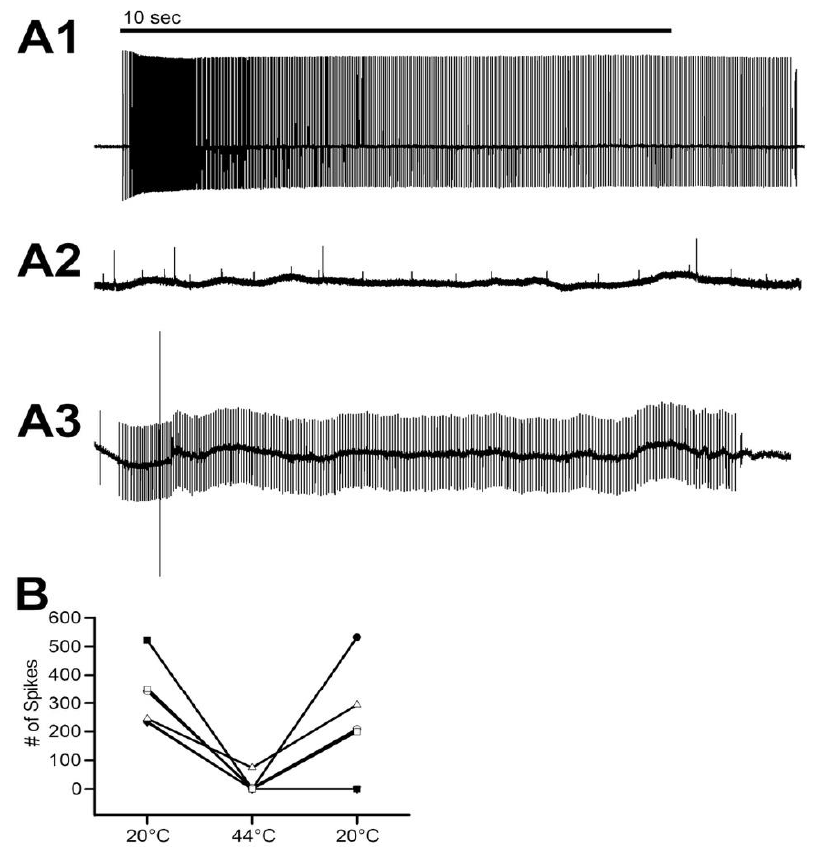
Figure 10. The activity of the MRO at various temperatures. ( A1 ) Representative trace of the Figure10. TheactivityoftheMROatvarioustemperatures. ( A1 )Representativetraceoftheextracellular extracellular 10 second activity of the MRO segmental nerve in saline at 20 °C. ( A2 ) Representative 10 s activity of the MRO segmental nerve in saline at 20 ◦ C. ( A2 ) Representative trace of the extracellular trace of the extracellular 10 second activity of the MRO segmental nerve at 44 °C. ( A3 ) Representative 10 s activity of the MRO segmental nerve at 44 ◦ C. ( A3 ) Representative trace of the extracellular 10 s trace of the extracellular 10 second activity at 20 °C after being at 44 °C for 1 min. ( B ) The mean number activity at 20 ◦ C after being at 44 ◦ C for 1 min. ( B ) The mean number of spikes for the 10 s activity for each MRO preparation at each temperature. The heating to 44 ◦ C had a significant e ff ect in reducing the of spikes for the 10 second activity for each MRO preparation at each temperature. The heating to 44 neural activity (N = 6, p < 0.05 non-parametric sign test). Each line represents individual preparations °C had a significant effect in reducing the neural activity (N = 6, p < 0.05 non-parametric sign test). and some of the symbols Each line represents individual preparations and some of the symbols overlap.